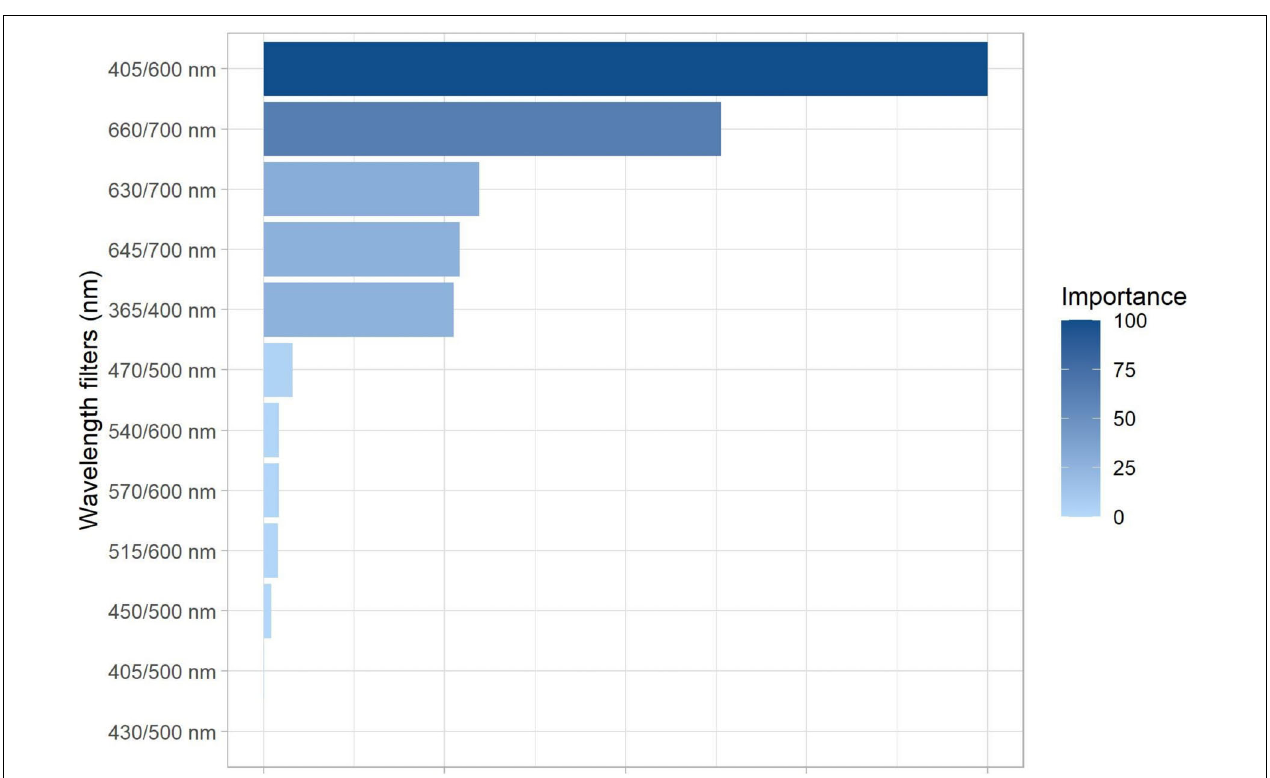
FIGURE 5 | Gini-based importance for each excitation/emission combinations in the random forest analysis to segment soybean seeds of different maturation stages: R7.1, R7.2, R7.3, R8, and R9 ( n = 500